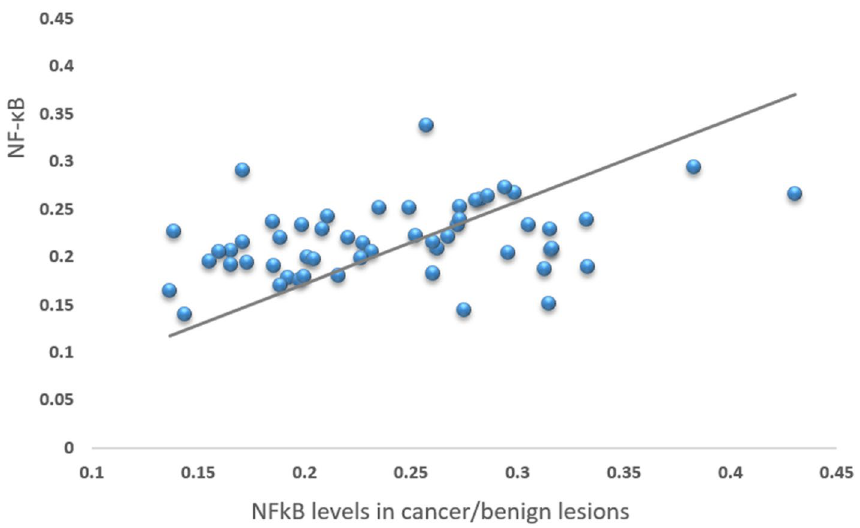
Figure 1. Correlation of NF-κB levels in normal vs pathological tissues. Data from all 56 patients are presented (p =